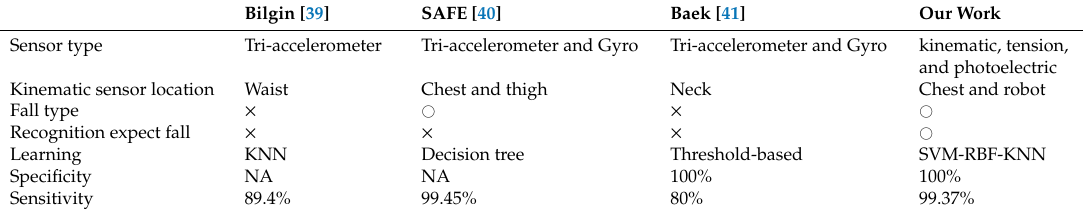
Table 3. Comparison between the proposed algorithm and state-of-the-art fall detection systems. KNN: k-nearest neighbors, RBF: radial basis function, SVM: support vector